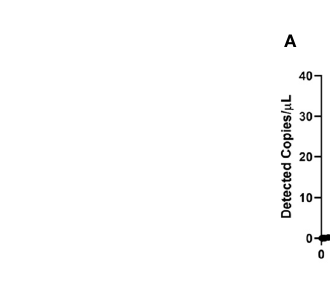
FIGURE 7 | Limit of quanti fi cation of ath-miR-159a (A) and hsa-miR-371a-3p (B) assays. The red arrow points to the number of copies that the assay can still reliably